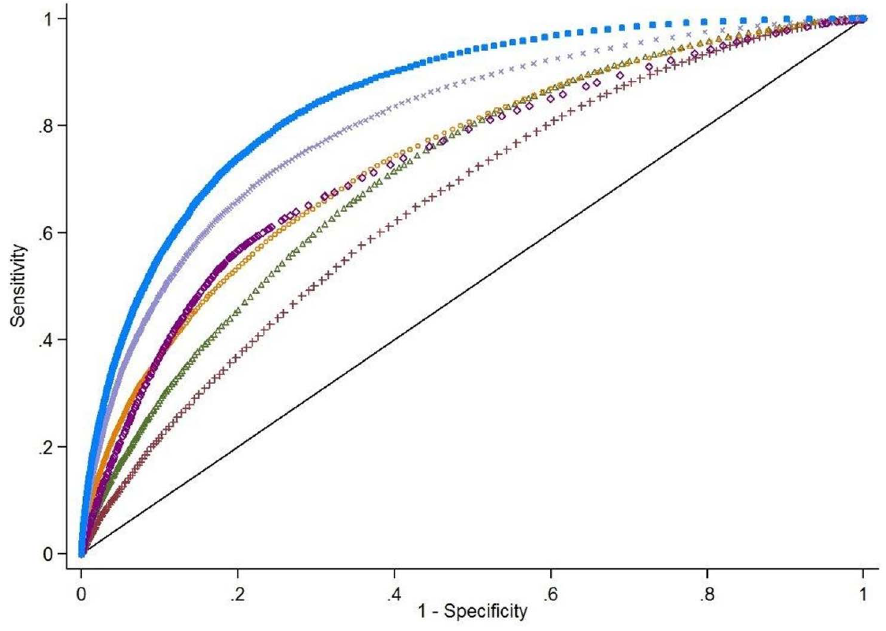
Figure 1. Comparison of Model Components’ Discrimination in the Derivation Cohort. Factors not significant at p , .05 and interaction terms are not included. All medications, tests and therapies are within the first 2 hospital days. Legend includes area under the ROC curve and 95%